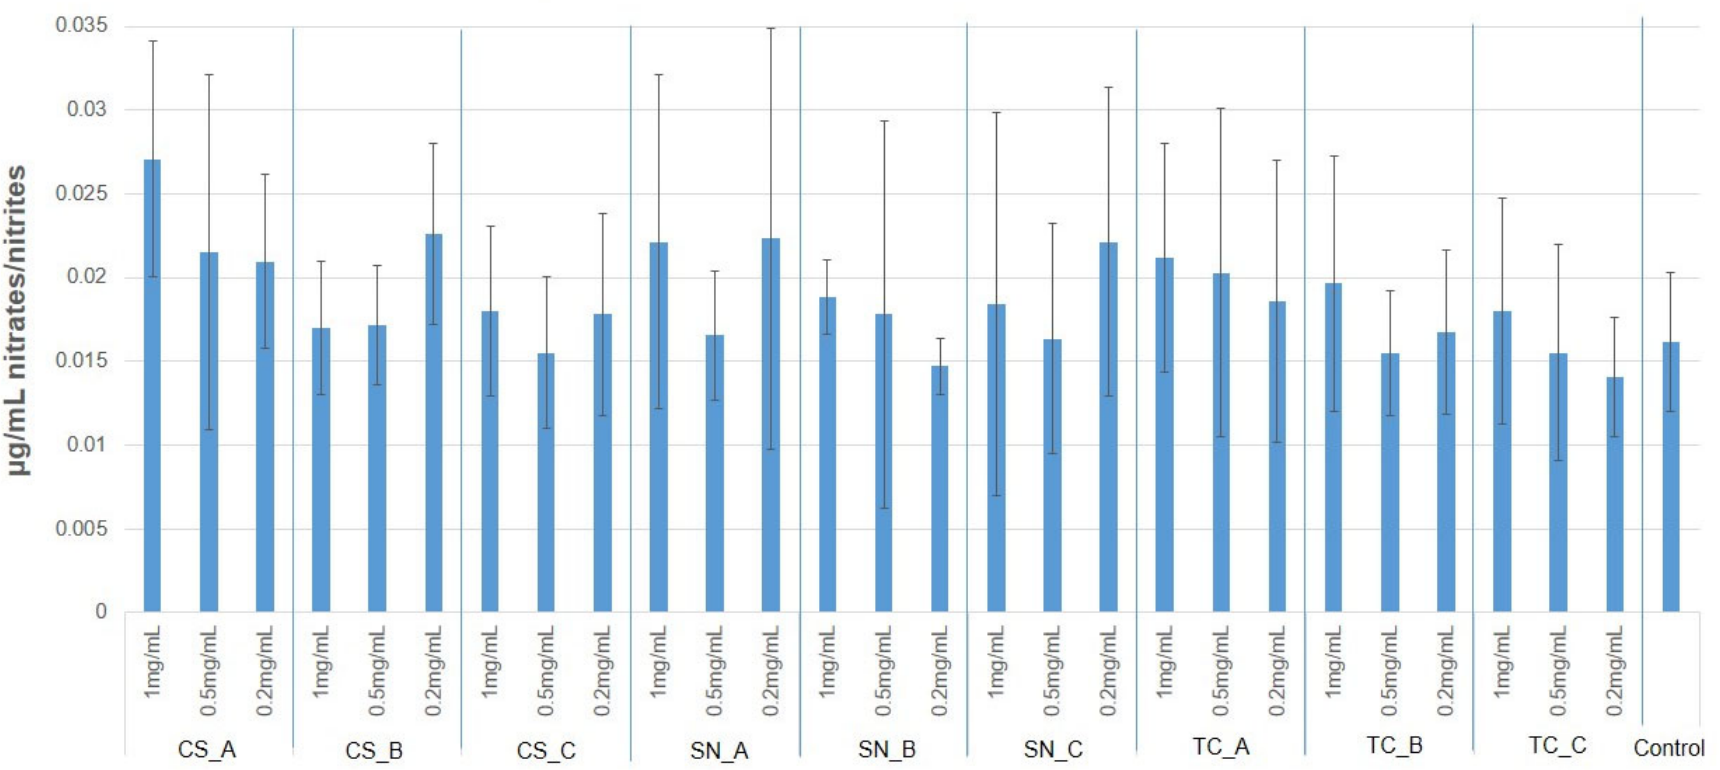
Figure 11. NO production of HaCaT cells, after treatment with nonexposed/exposed to acidic artificial saliva of CAD/CAM restorative materials powders, at three tested concentrations (1 mg/mL; 0.5 mg/mL, and 0.2 mg/mL).